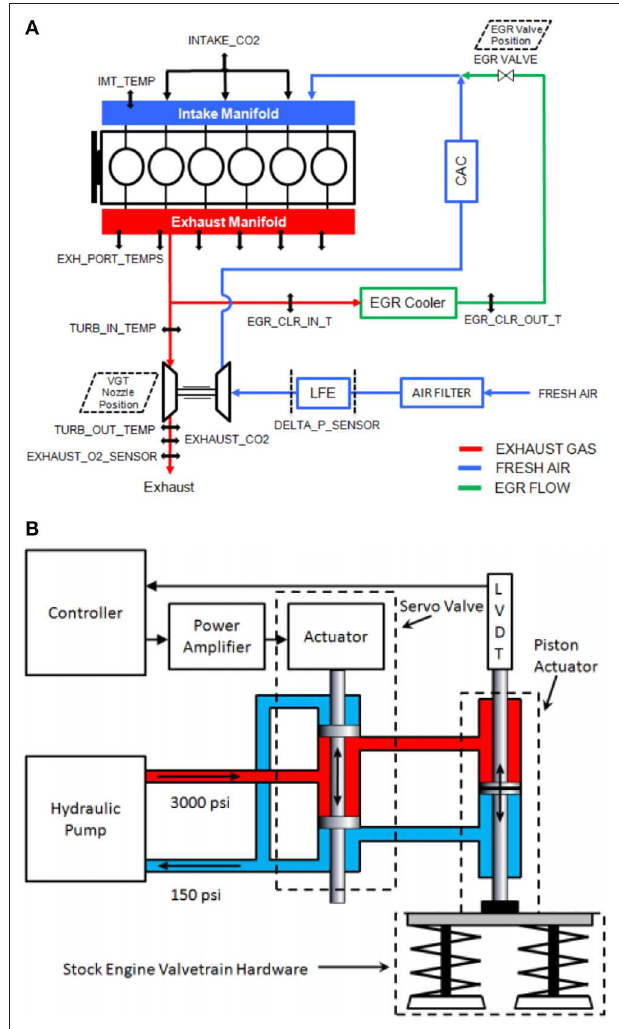
FIGURE 2 | (A) Schematic drawing of the air handling system of the engine with the location of sensors having been labeled. (B) Schematic of the variable valve actuation